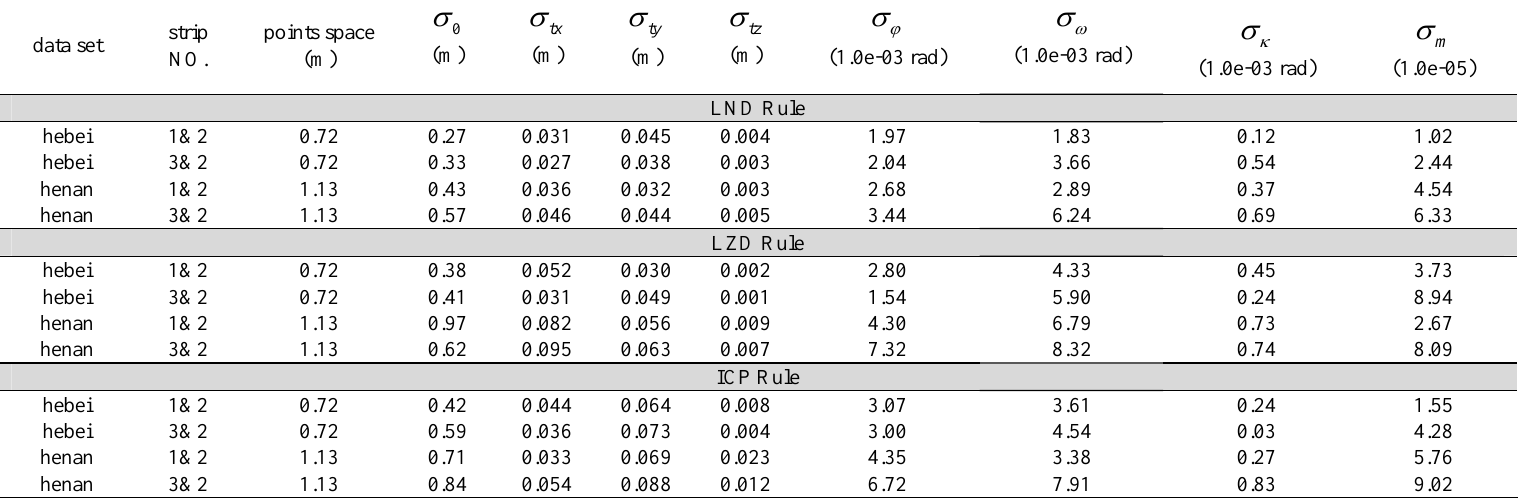
Table 3. Accuracy assessment for least squares 3D surface matching. (Theoretical accuracy and error of unit weight are listed in table 3 and the LND rule has best